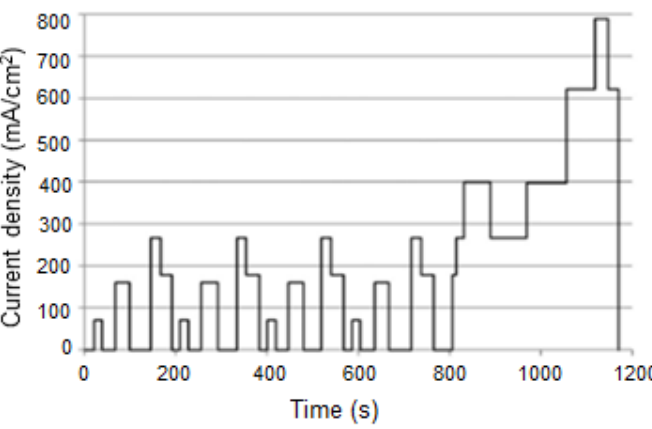
Figure 9. Tongji university test protocol [4] (Reproduced with permission from Huicui et al. [4], Applied Energy; published by Elsevier Ltd., 2018).